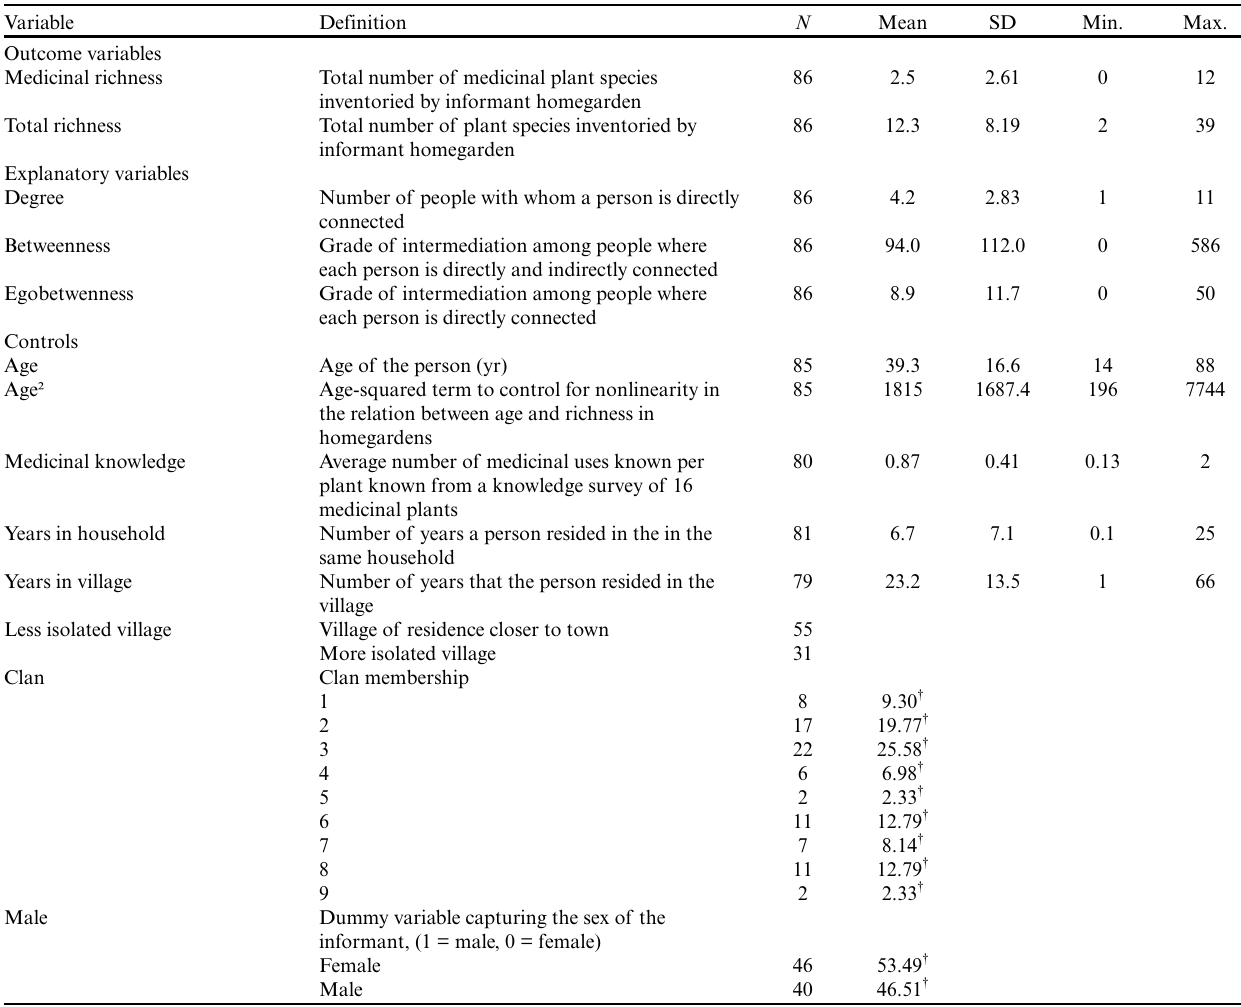
Table 2. Definition and descriptive statistics for variables used in the multivariate